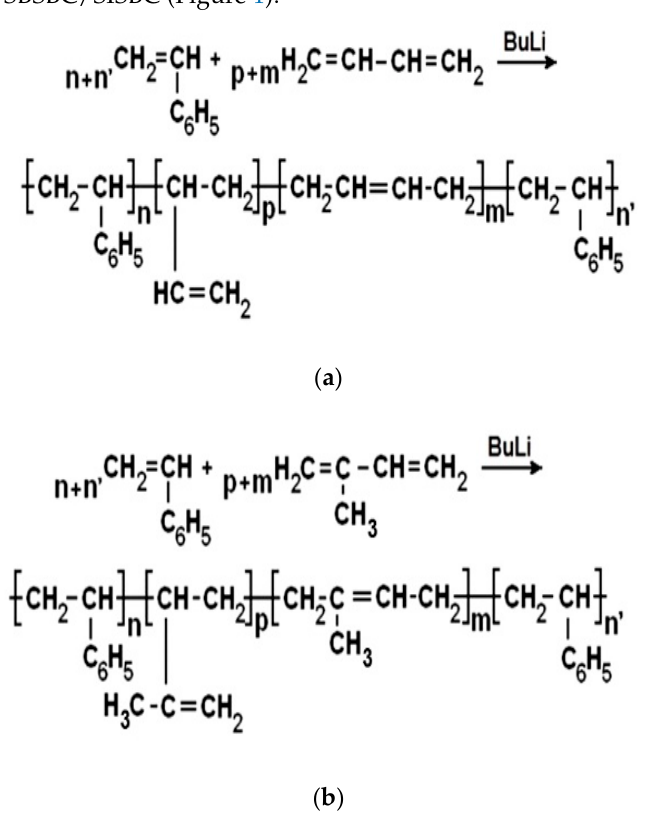
Figure 1. Synthesis of SBSBC ( a ) and SISBC ( b ) by three sequential anionic polymerizations. Evaluation of the molecular weight, and mechanical and thermal properties, for the synthesized SBSBC and SISBC was performed on 1-mm thick films obtained by centrifugal casting of the elastomer solutions into toluene, using gel permeation chromatography (GPC) and tensile, hardness, melt flow index, and dynamic mechanical measurements (Table 1). Table 1. Characteristics of the synthesized styrene-diene block-copolymers.